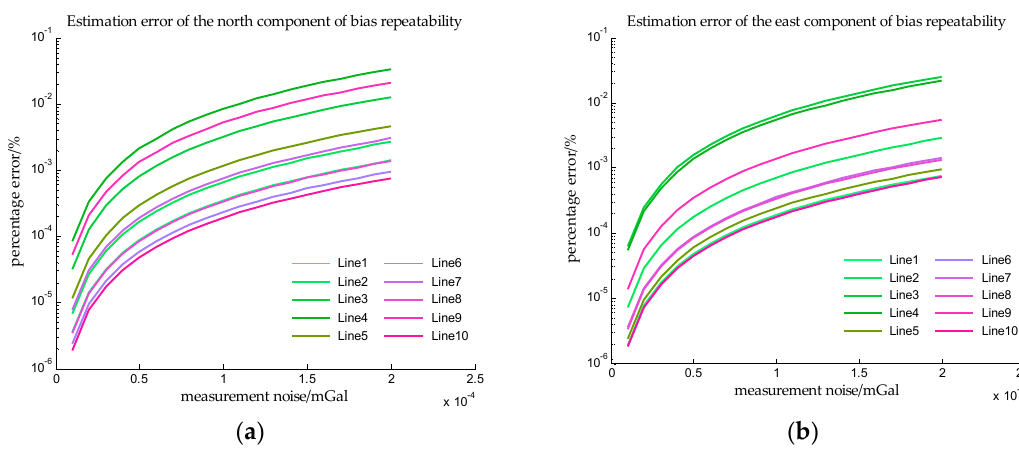
Figure 19. The estimation error of the bias repeatability on the short survey lines in simulation VI. ( a ) Is the estimation error of the north component of the bias repeatability, and ( b ) is the estimation error of the east component of the bias repeatability.